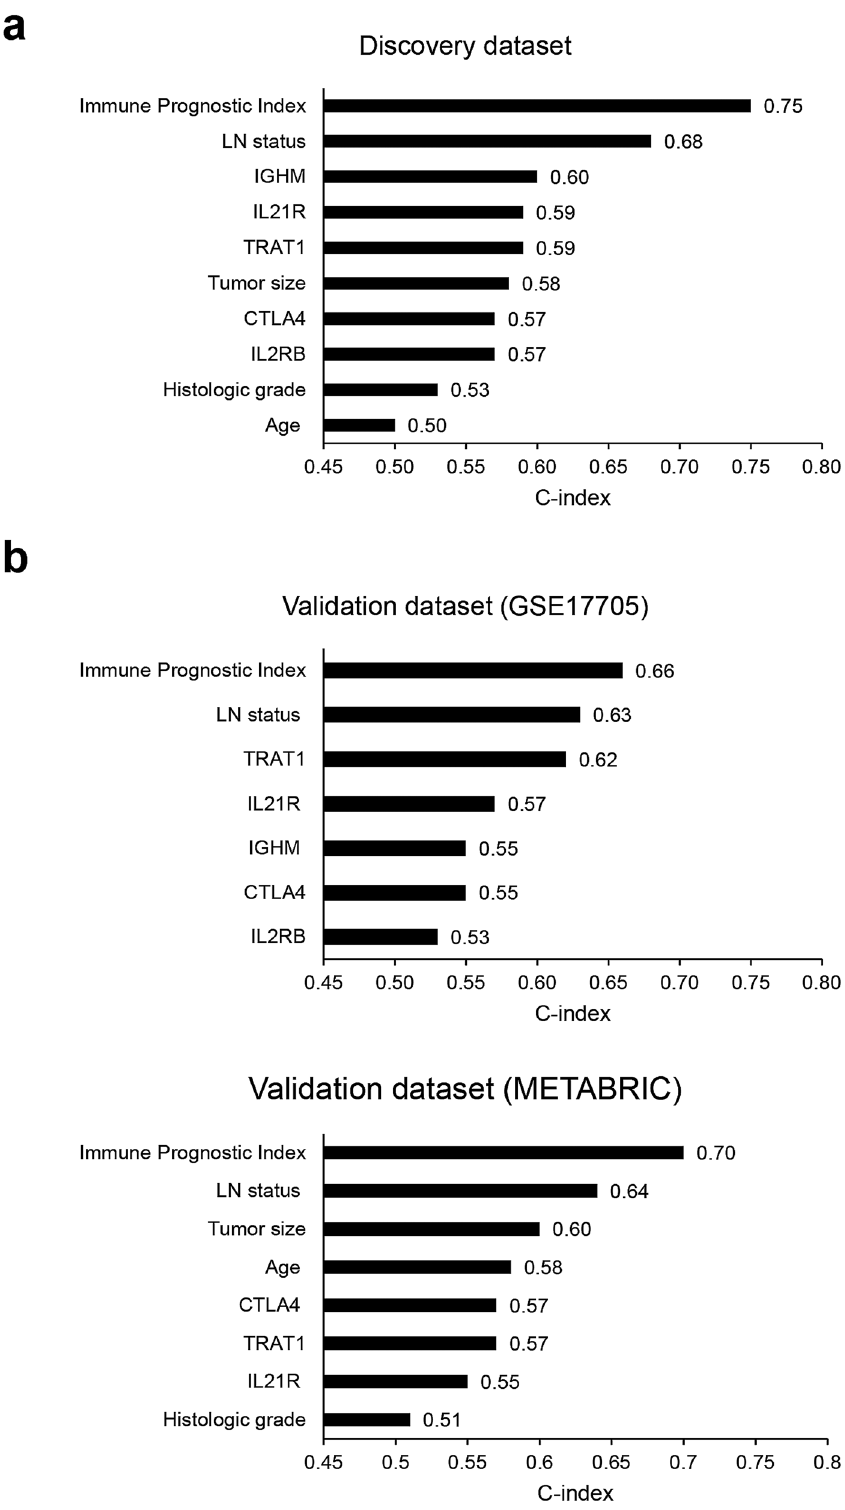
Figure 3. The C-index comparing the prognostic performance of the immune prognostic index for predicting patient survival with that of clinicopathological variables. ( a ) Discovery dataset ( b ) Validation datasets (top, GSE17705; bottom, METABRIC). Values on the x-axis indicate C-index estimates for clinical/gene variables and the immune prognostic